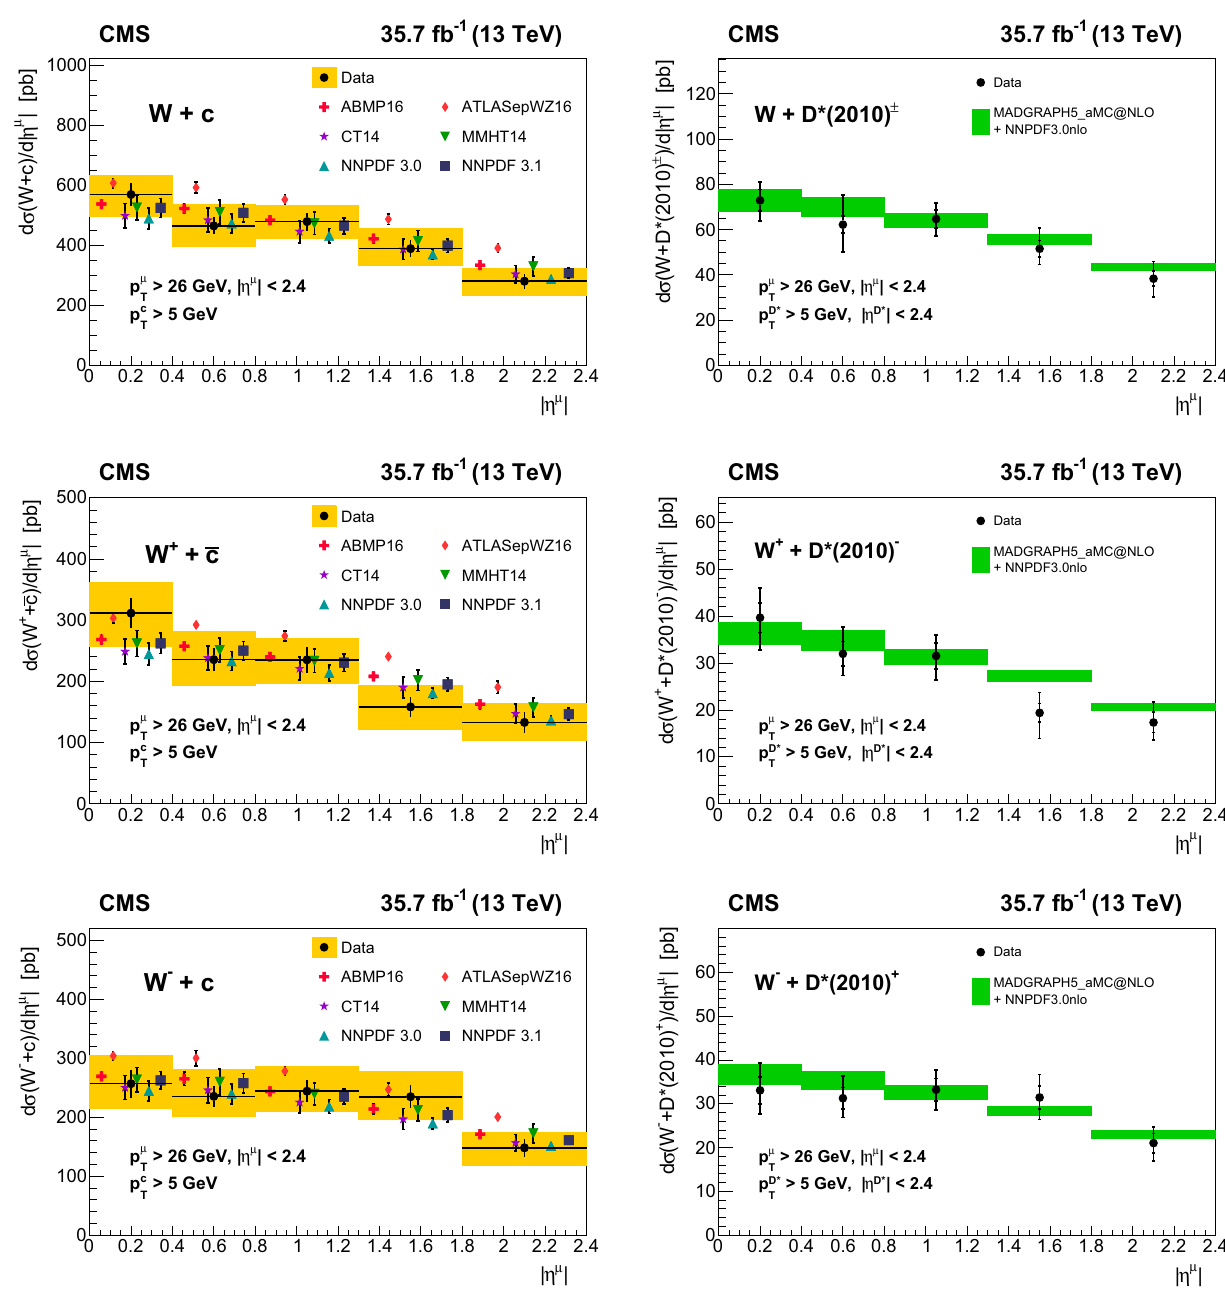
Fig. 5 Left: Differential cross sections of σ( W + c ) production at 13TeV measured as a function | η μ | . The data are presented by filled circles with the statistical (total) uncertainties shown by vertical error bars (light shaded bands). The measurements are compared to the QCD predictions calculated with mcfm at NLO using different PDF sets, pre- sented by symbols of different style. All used PDF sets are evaluated at NLO, except for ATLASepWZ16, which is obtained at NNLO. The error bars represent theoretical uncertainties, which include PDF and